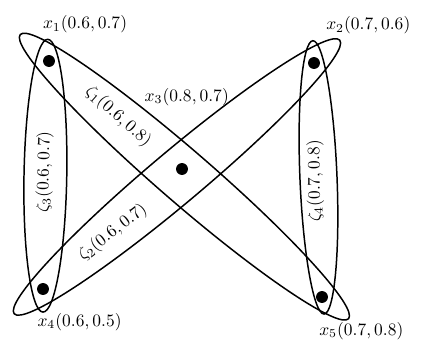
Figure 4. -tempered three-rung orthopair fuzzy B